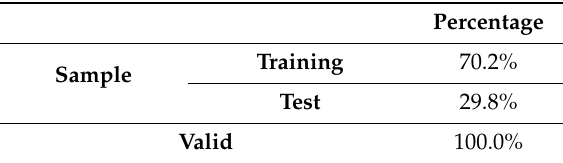
Table 4. Case allocation summary for Value.